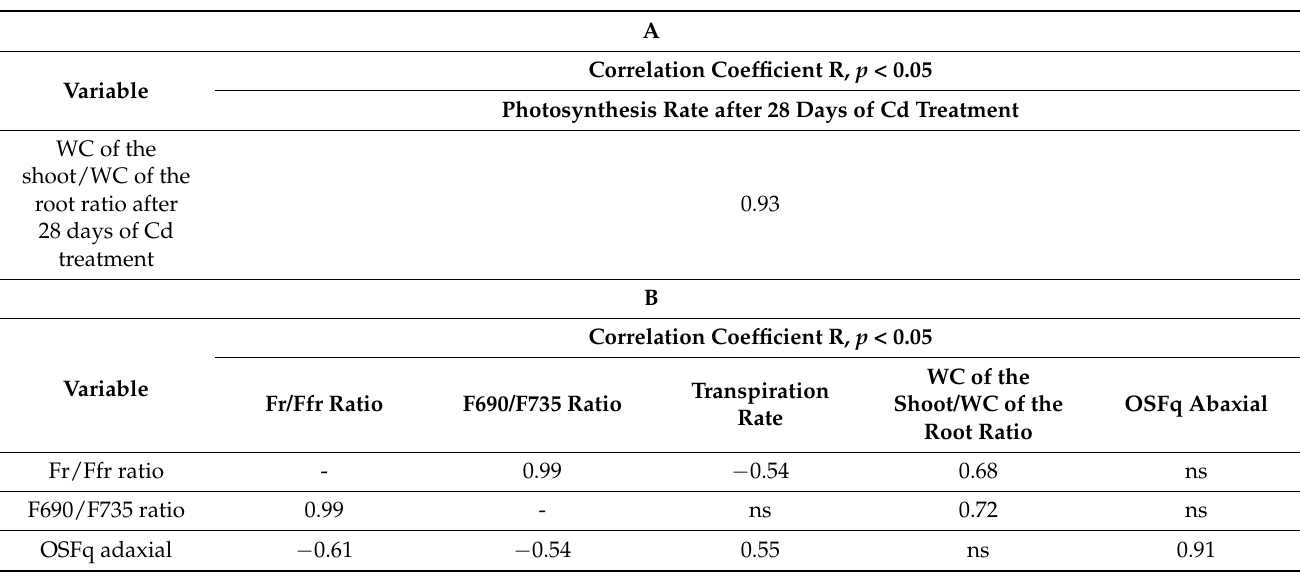
Table 1. (A,B). The statistically significant results of the correlation analysis presented as Pearson’s correlation coefficients